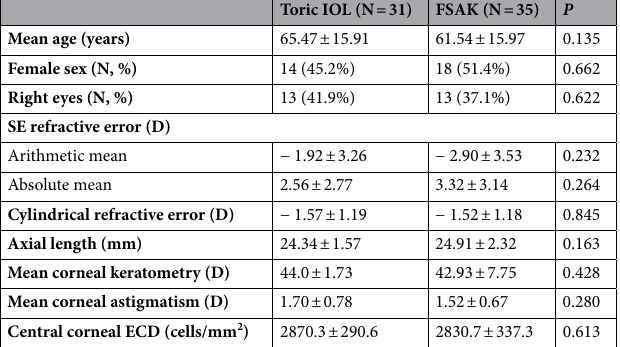
(Table 3). In addition, the corneal astigmatism was divided into two forms, with-the-rule (a steep axis within 30° of the vertical meridian, WTR) and against-the-rule (a steep axis within 30° of the horizontal meridian, ATR).